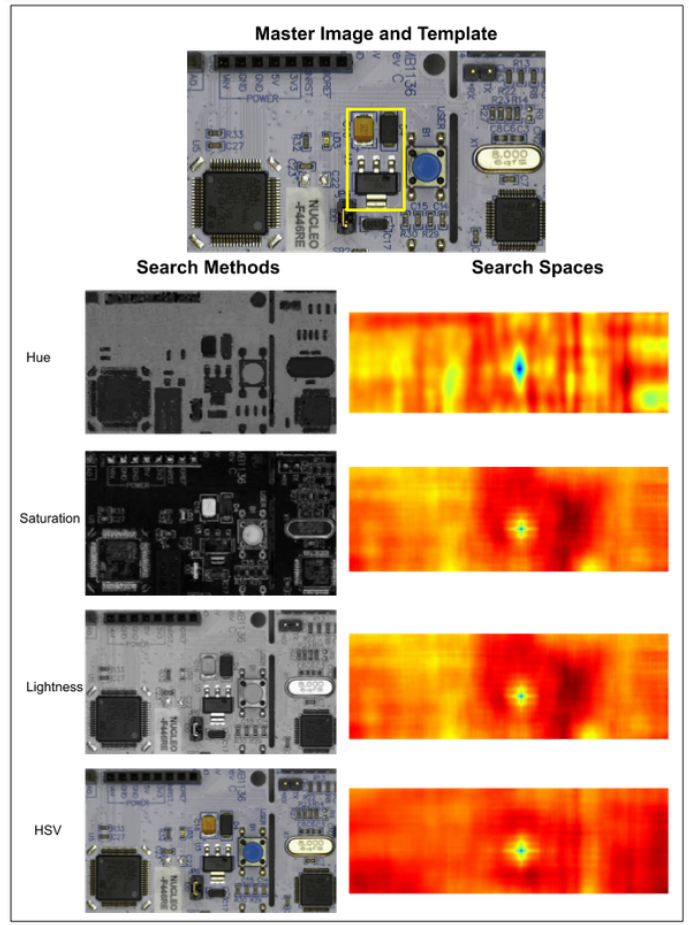
Figure 4. Loss in HSV for image template matching (right) over an example image (top) to a section of the image (yellow box). Blue indicates no loss and dark red indicates the maximum